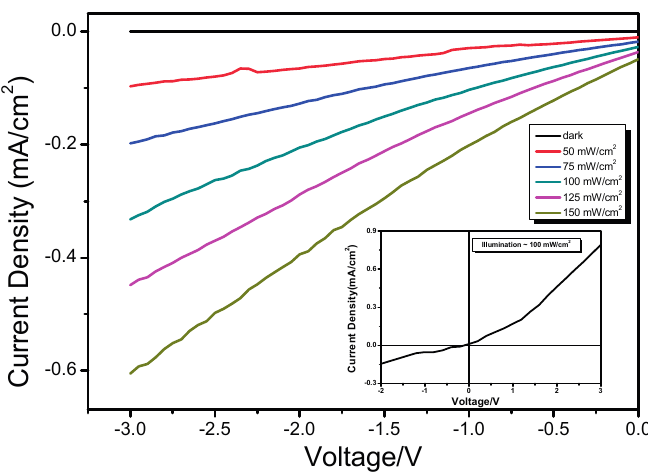
Figure 5. The photoresponce characteristics of the OPD (ITO/PEDOT:PSS/PFO- DBT:MEH-PPV:PC 71 BM/LiF/Al) illustrating photocurrent dependence on light illumination levels. The measurements were recorded under different light intensities from 0 to 150 mW/cm 2 , at room temperature. Inset shows the I-V characteristics of the OPD under forward and reverse biased condition at room temperature.